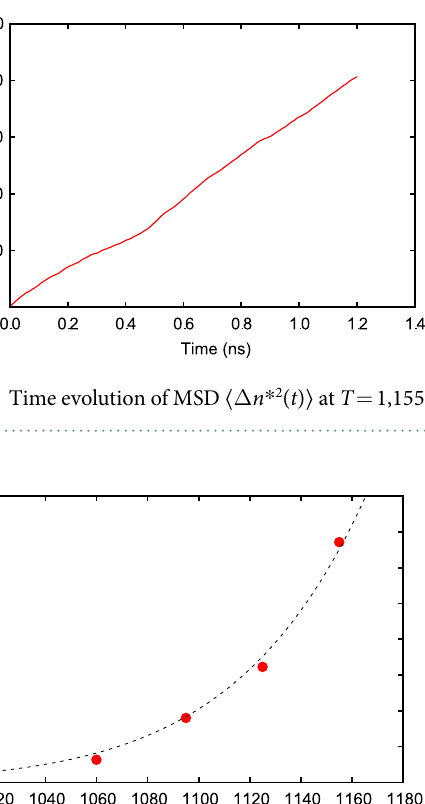
where A and B denote fitting parameters. The values of A and B are summarized in Table S4. It is worth not- ing that recent theoretical crystallization study for a Lennard-Jones system 15 shows a super-Arrhenius behav- ior of the attachment rate. Actually our attachment rate data of Cu 20 Zr 80 also seem to exhibit super-Arrhenius like behavior, while data of Cu 50 Zr 50 do not clearly exhibit at least within the examined temperature range (see